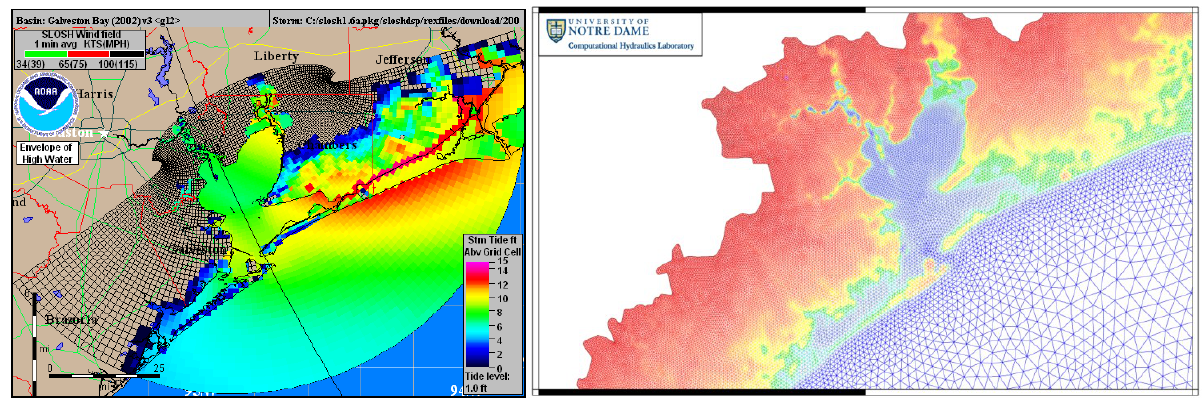
Figure 2. ( left ) The structured (curvilinear orthogonal) grid SLOSH model. ( right ) The unstructured (triangular) grid ADCIRC